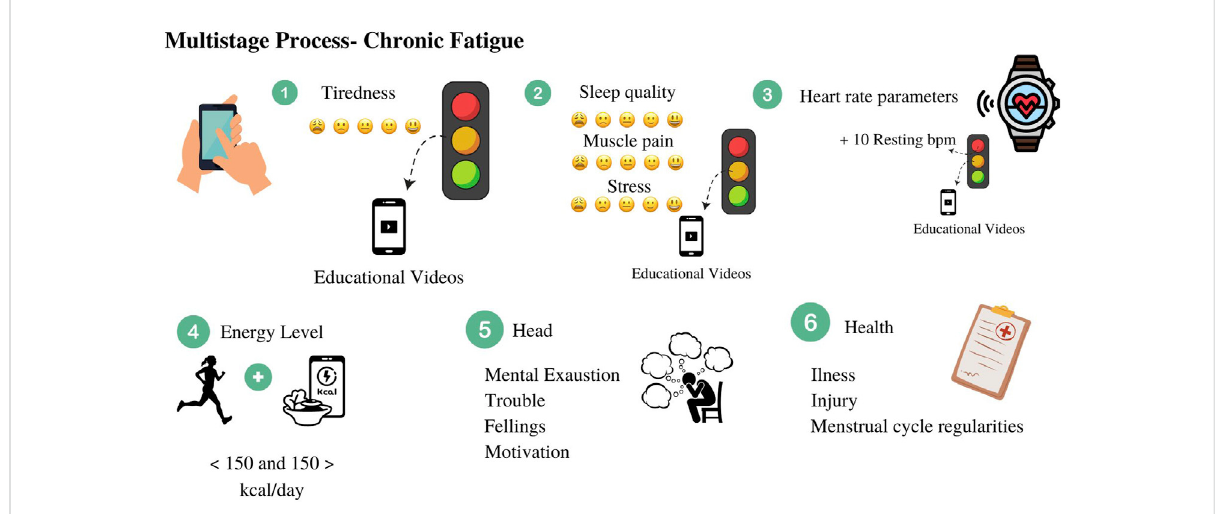
FIGURE 2 Training parameters assessed in a multisatge process of alertness for chronic